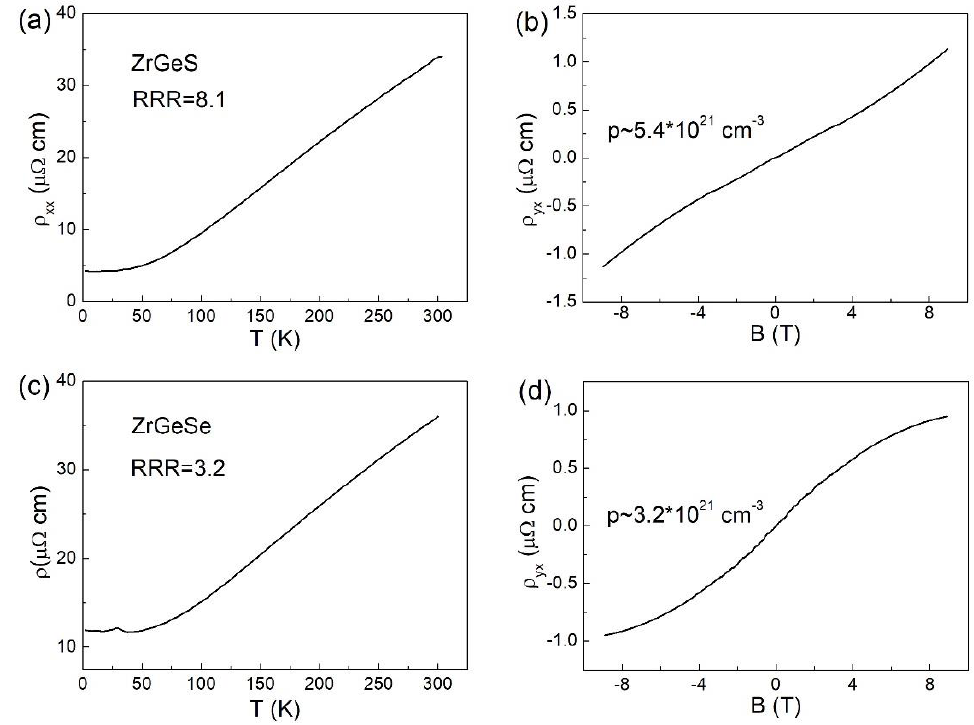
Figure 5. ( a ) The temperature dependence of longitudinal resistivity ( ρ xx ), and ( b ) the field dependence of the Hall resistivity ( ρ yx ) measured at 2 K for ZrGeS. ( c , d ), which is the same as in ( a , b ), but for ZrGeSe. The measurement configurations are the same as in the Figure 4.